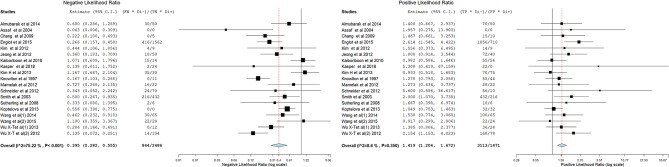
Forest plot showing negative and positive likelihood ratios of the II-MSI studies (individual studies: size of the squares are proportional to weights used in meta-analysis; the summary measure: center line of the diamond; associated 95% confidence intervals: lateral tips of the squares and the diamond).